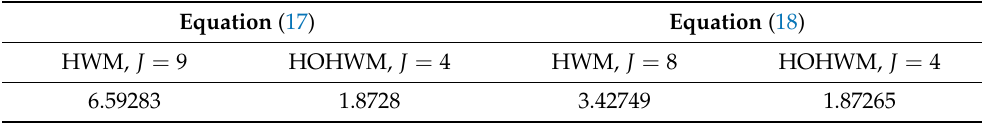
Table 11. CPU times for solutions of Equations (17) and (18) at the same level of